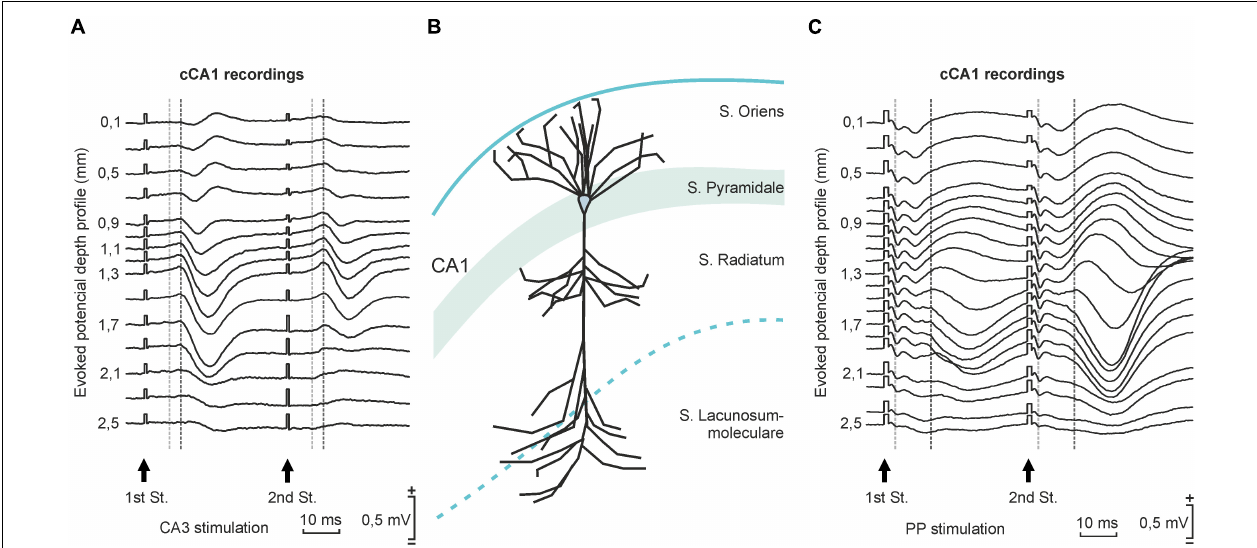
FIGURE 1 | Selective examples of preliminary depth-profile recordings that help to characterize the fEPSPs evoked at the contralateral CA1 synapses included in this study. (A) Depth-profile representation of fEPSPs evoked in the contralateral CA1 area by paired-pulse stimulation (40 ms of interpulse interval, red arrows) of Schaffer collaterals (CA3 stimulation). Stimulus intensity was set at 40% of the intensity (mA) necessary to evoke maximum fEPSP responses at 1.3 mm depth. Recordings were carried out in steps of 100 and 200 µ m. Note that the latency of the fEPSP (dark gray) is longer than the one for the homolateral CA3-CA1 synapse, i.e., stimulating and recording in the same hemisphere (light gray; obtained from Gruart et al., 2015). (B) A diagrammatic representation of the location of somas and dendrites corresponding to CA1 pyramidal cells and to dentate granule neurons. The different strata are indicated. (C) Another field-potential depth profile corresponding to fEPSPs evoked in the contralateral CA1 area by the paired-pulse stimulation of the ipsilateral perforant pathway.